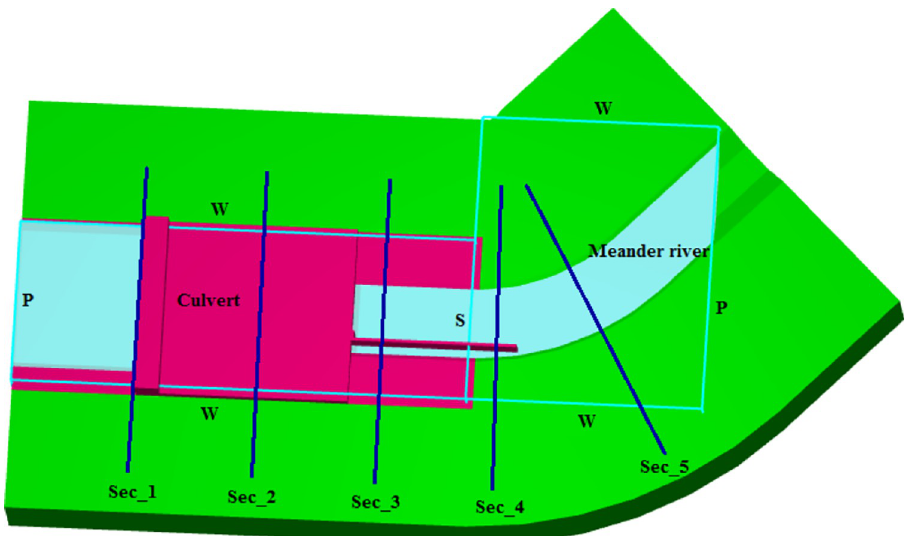
Fig 2. Configuration of the computational